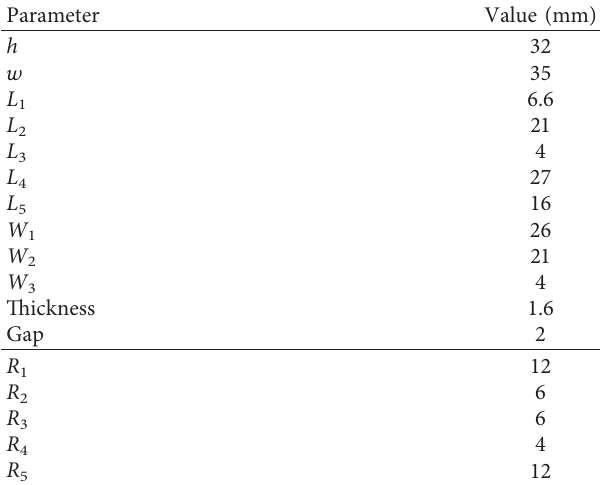
Figure 4: S 11 simulation results of each configuration. Table 2: Dimensions of the proposed